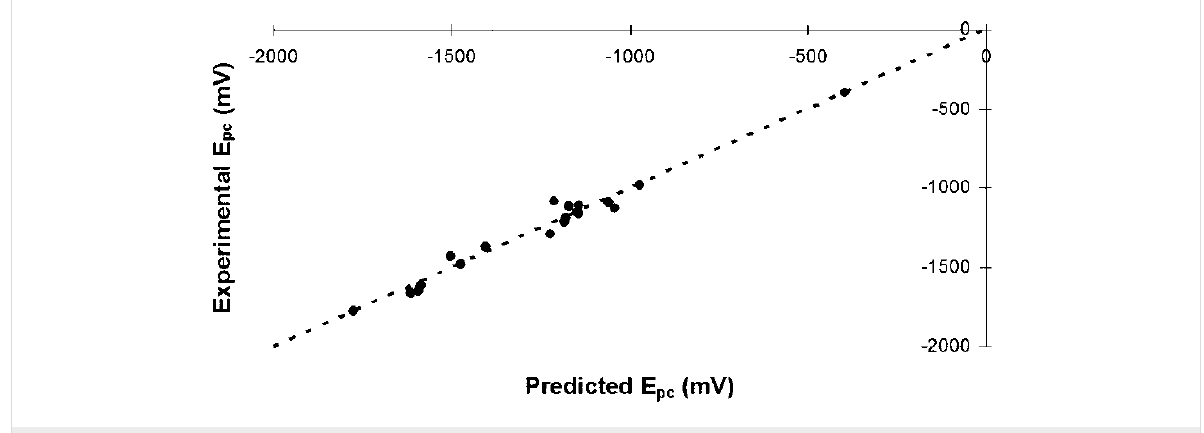
Figure 4: Comparison of experimental and predicted E pc for all training set metal-salens.